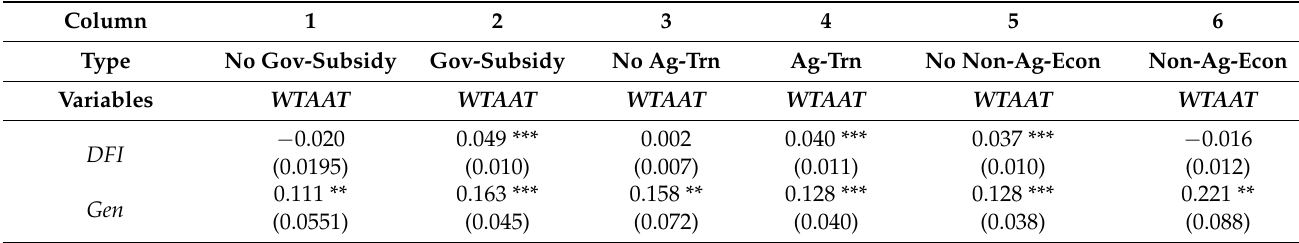
Table 5. Heterogeneity analysis.